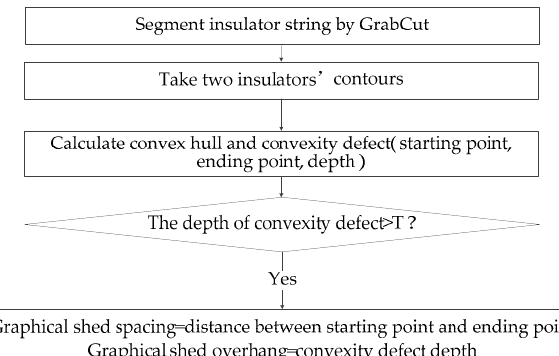
Figure 5. Computation of graphical shed spacing and graphical shed overhang.